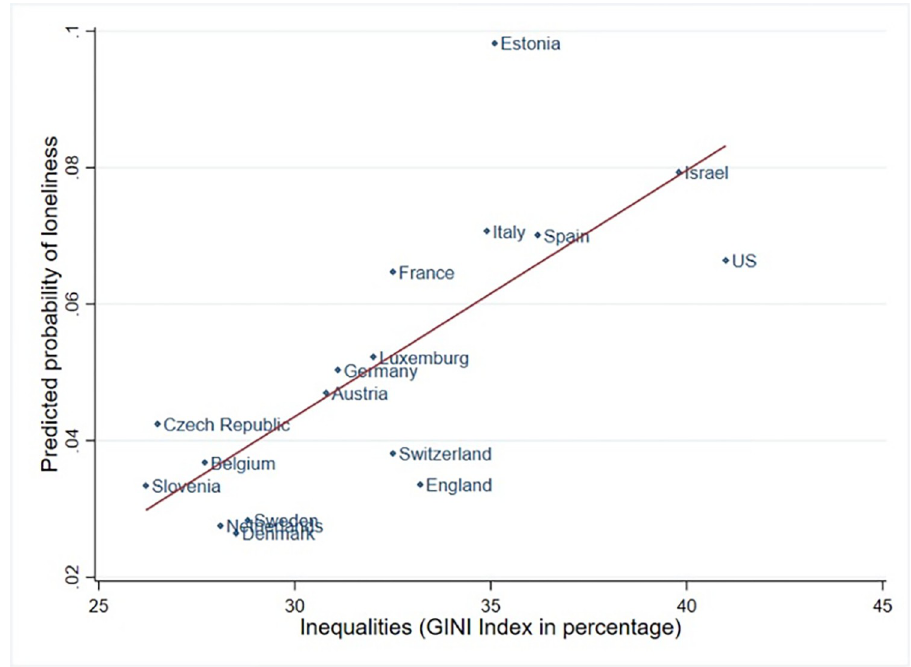
Fig 2. Country predicted probabilities for loneliness and inequality level. Note: Probability of loneliness based on model 4. Model 3 explained 24% of the variation of loneliness (M&Z R 2 = 0.243). A unit-increment